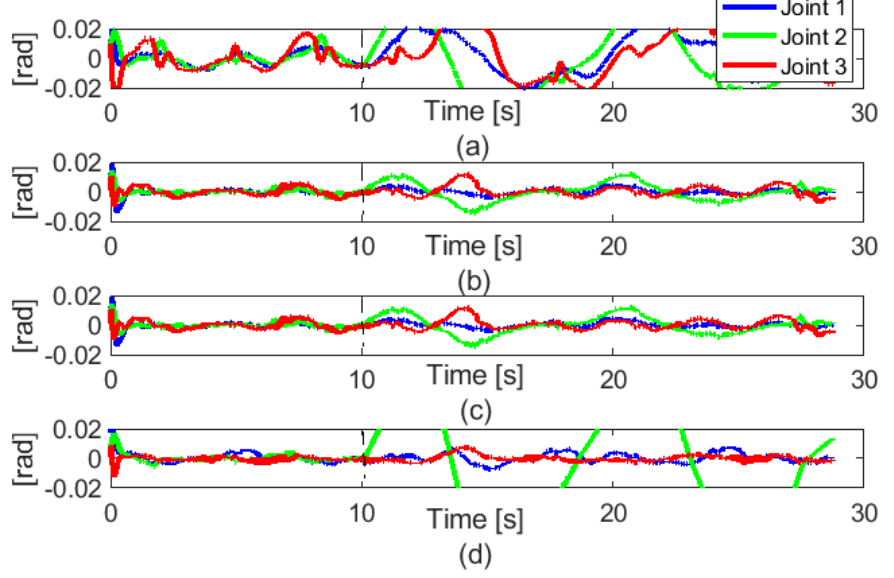
Figure 9. Tracking error results with difference group value of ψ . ( a ) ψ 1 = ψ 2 = ψ 3 = ψ = 1.5; ( b ) ψ 1 = ψ 2 = ψ 3 = ψ = 3.5; ( c ) ψ 1 = ψ 2 = ψ 3 = ψ = 4.5; ( d )